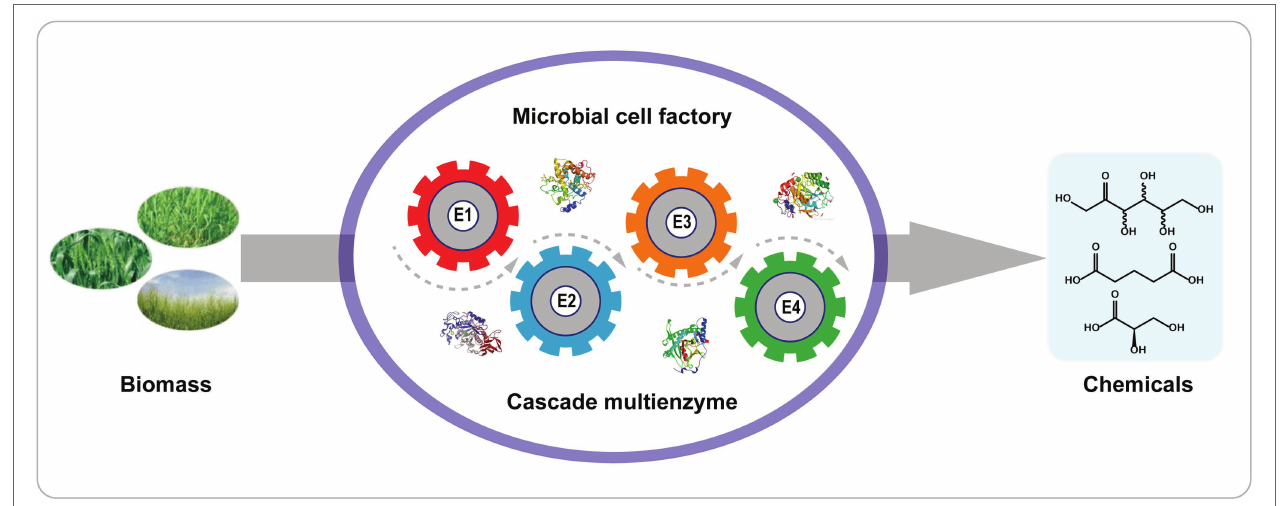
FIGURE 4 | Cascade biotransformation with a single recombinant cell. E1–E4 represent enzyme